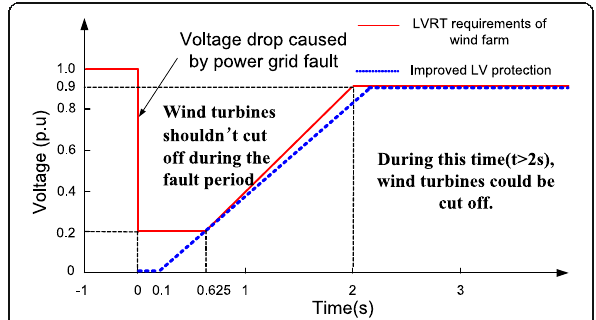
Fig. 11 Improved low voltage protection curve of